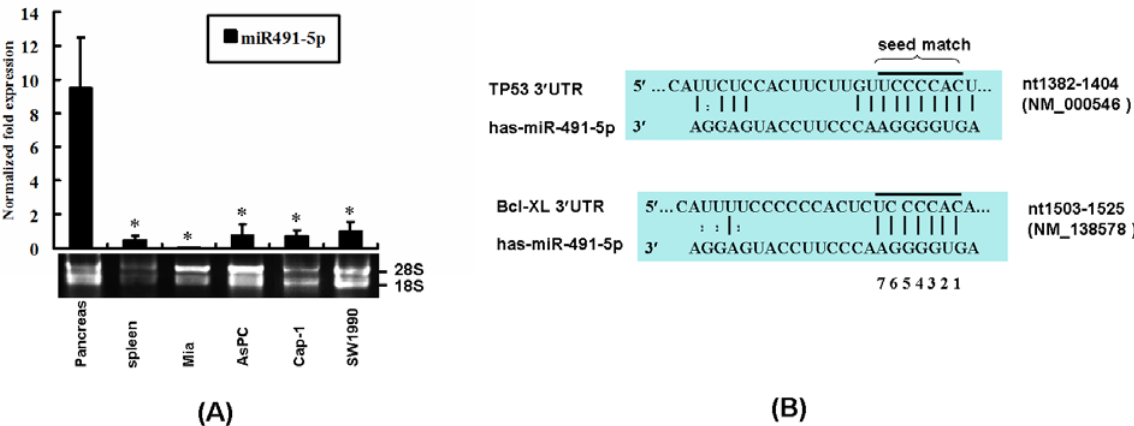
poly(A) qRT-PCR analysis on miR491-5p expressions in the total RNAs isolated from selected human tissues (spleen and pancreas) and four pancreatic cancer cell lines (Mia, AsPC, Cap-1 and SW1990). The integrity of RNA samples was assessed by gel electrophoresis to visualiz the presence of 18S and 28S RNAs. Data represented as mean ± SD from four independent experiments. The difference was calculated by student’s t test. Significant difference was indicated as  p < 0.01; ( B ) Targeted site prediction of miR491-5p on the 3' UTR of TP53 and Bcl-XL. The seed match region for each targeted gene was